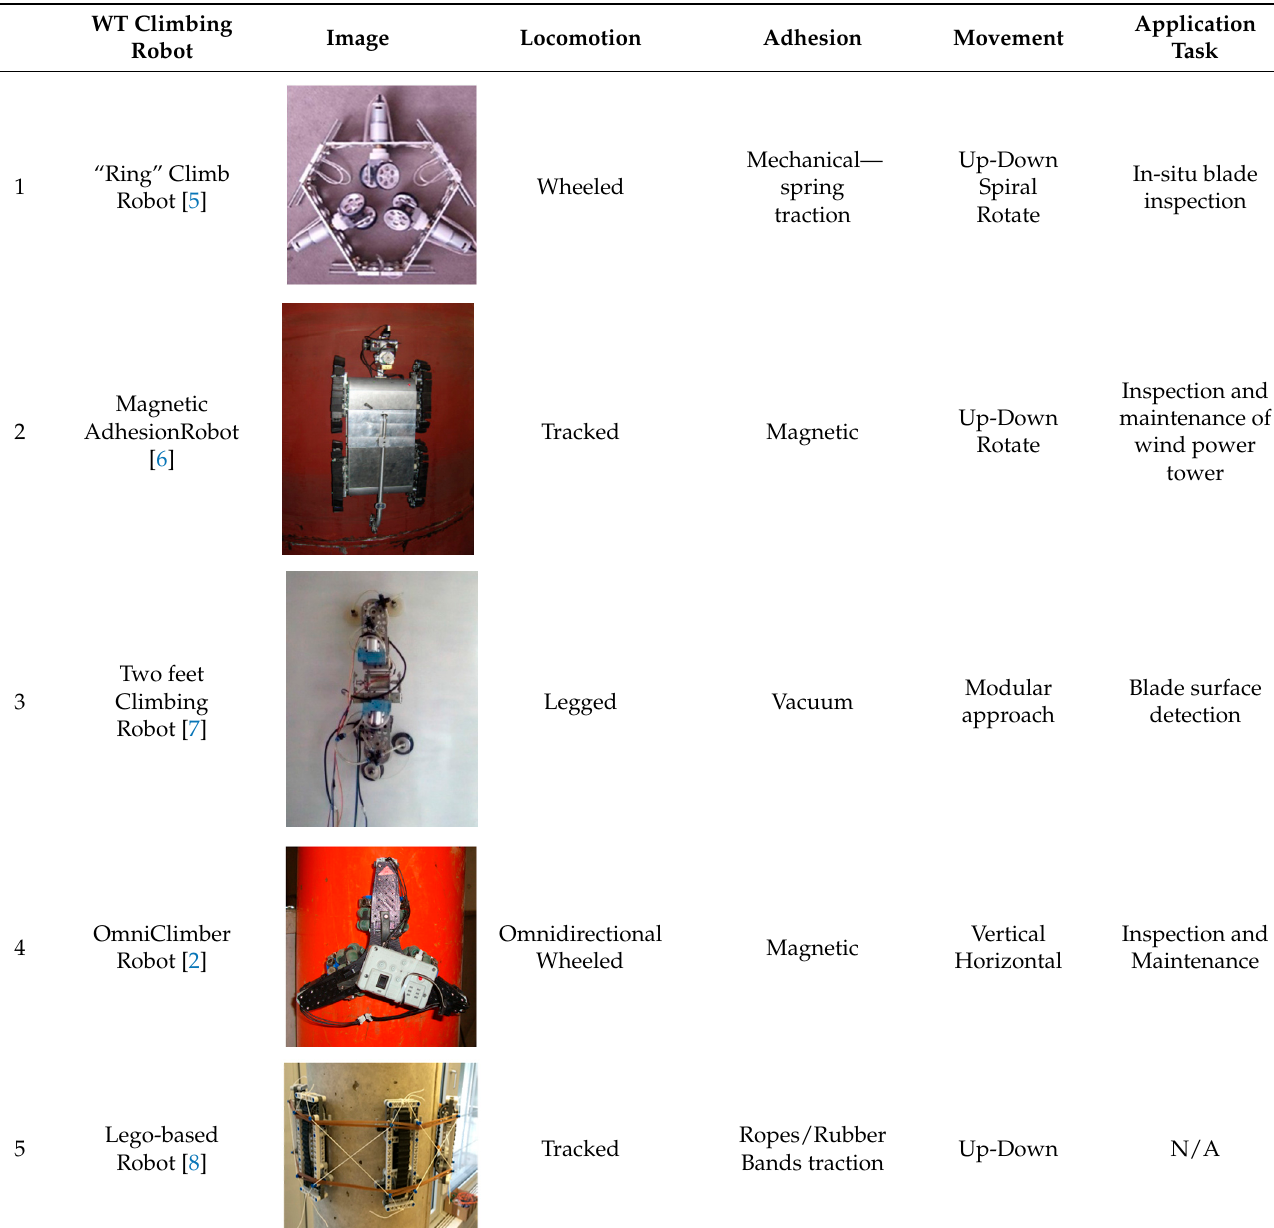
Table 1. Climbing robots used for wind turbine applications.